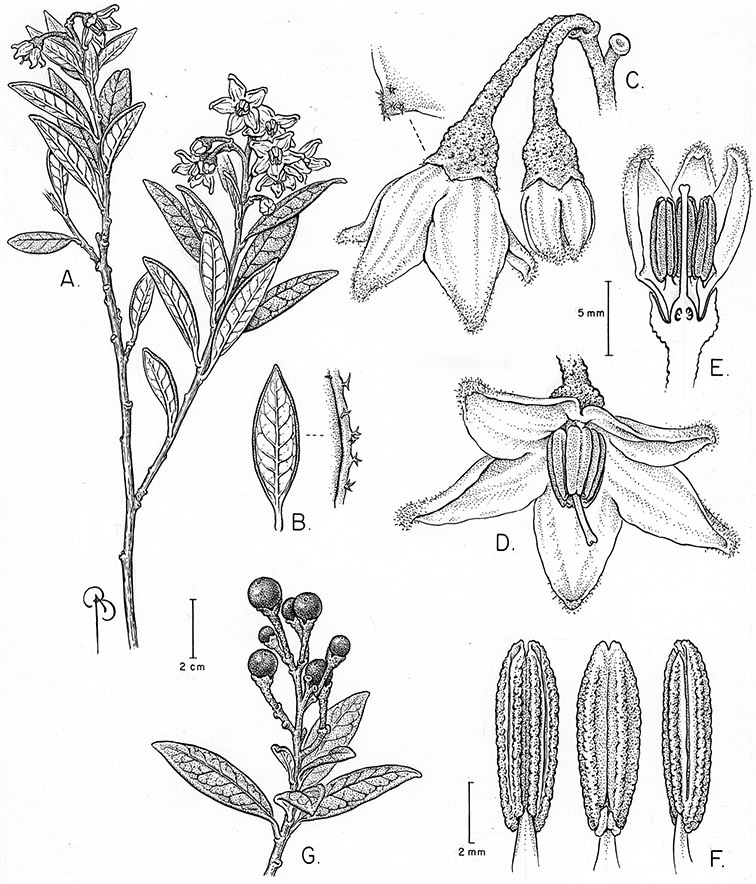
Solanum coalitum S. Knapp. (A, B drawn from Jorgensen 2188
C D drawn from G. Lewis photographs of Lewis 3179). Illustration by Bobbi Angell.